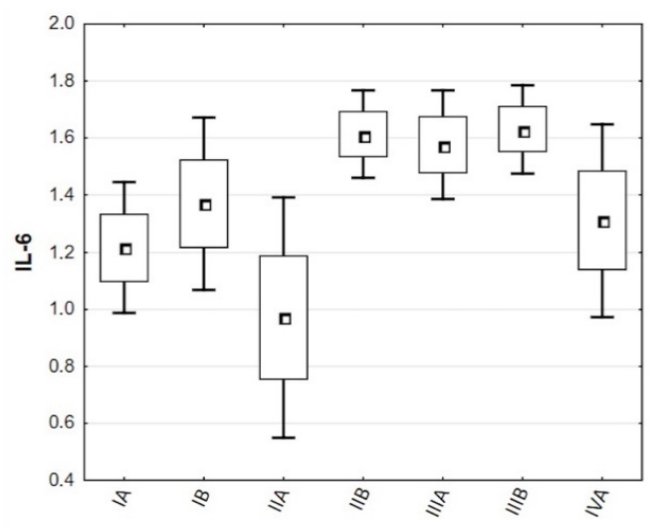
Figure 3. Distribution of IL-6 concentrations among lung cancer stages.